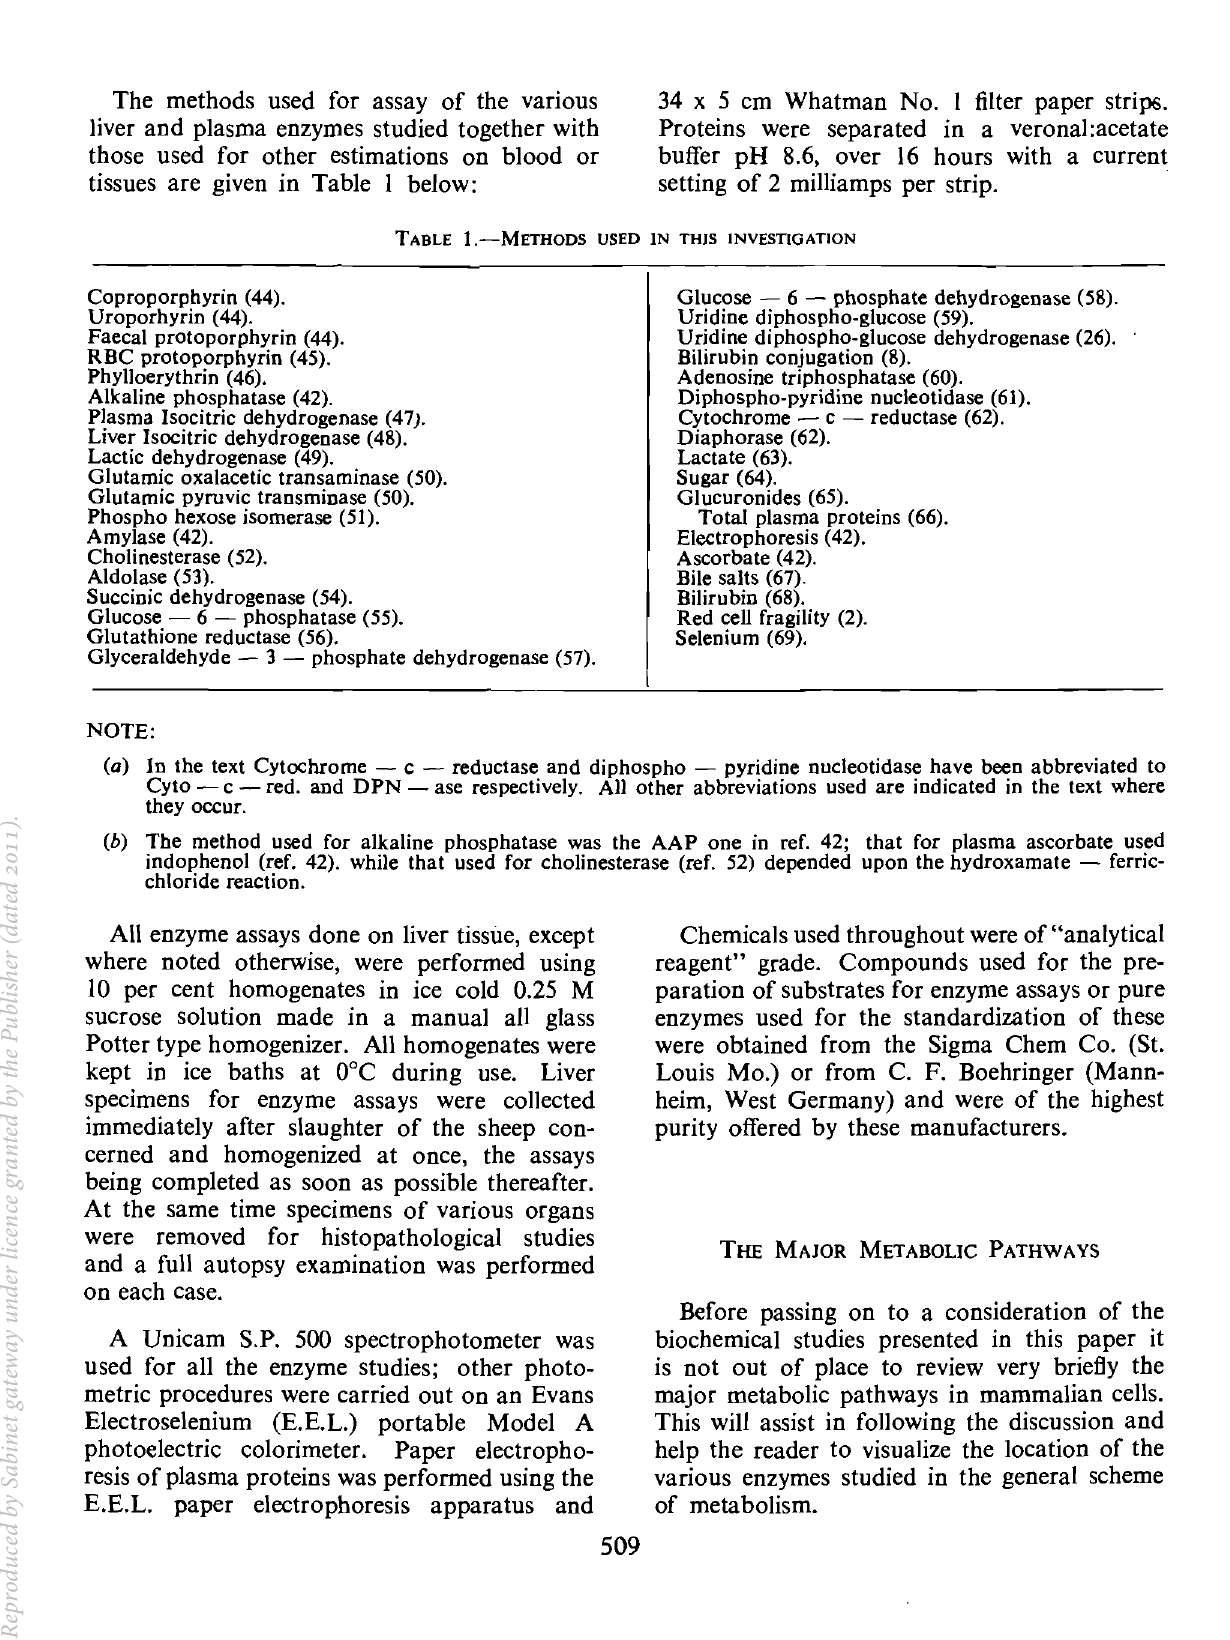
TABLE I.-METHODS USED IN THIS